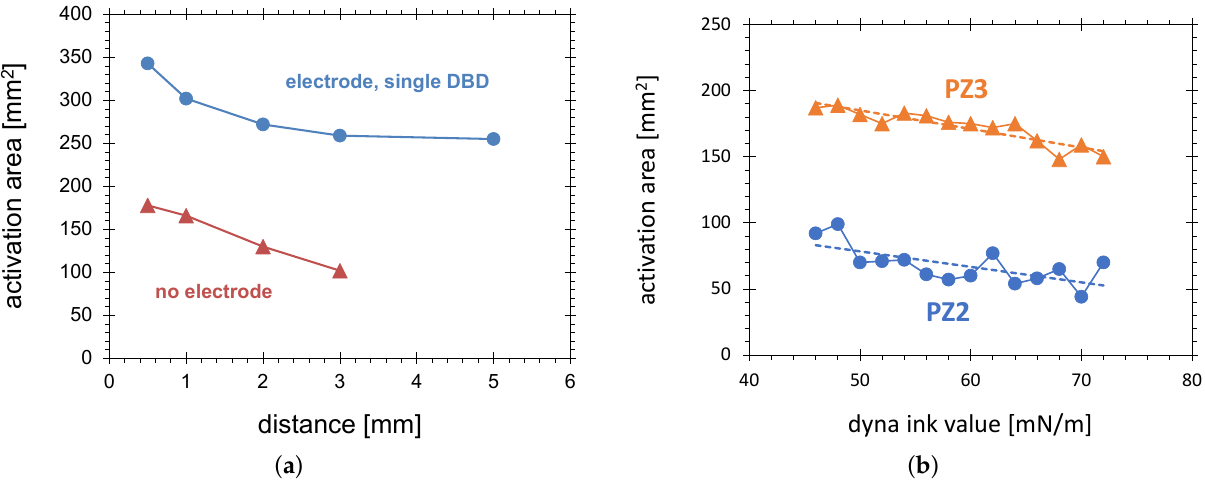
Figure 15. Comparison of activation area for different DBD configurations. ( a ) dependence of the activation area on HDPE visualized using test ink gauged 58 mN/m on the distance between the dielectric barrier and the substrate for the DBD configuration without excitation electrode (see Figure 11b) and with excitation electrode and single DBD (see Figure 11c); ( b ) dependence of the activation area visualized on the ABS substrate with test inks gauged from 46 to 72 mN/m for single (PZ3) and double (PZ2) DBD. Treatment time: 10 s. PCPG power: 8 W. Distance between substrate and the dielectric barrier: 0.5